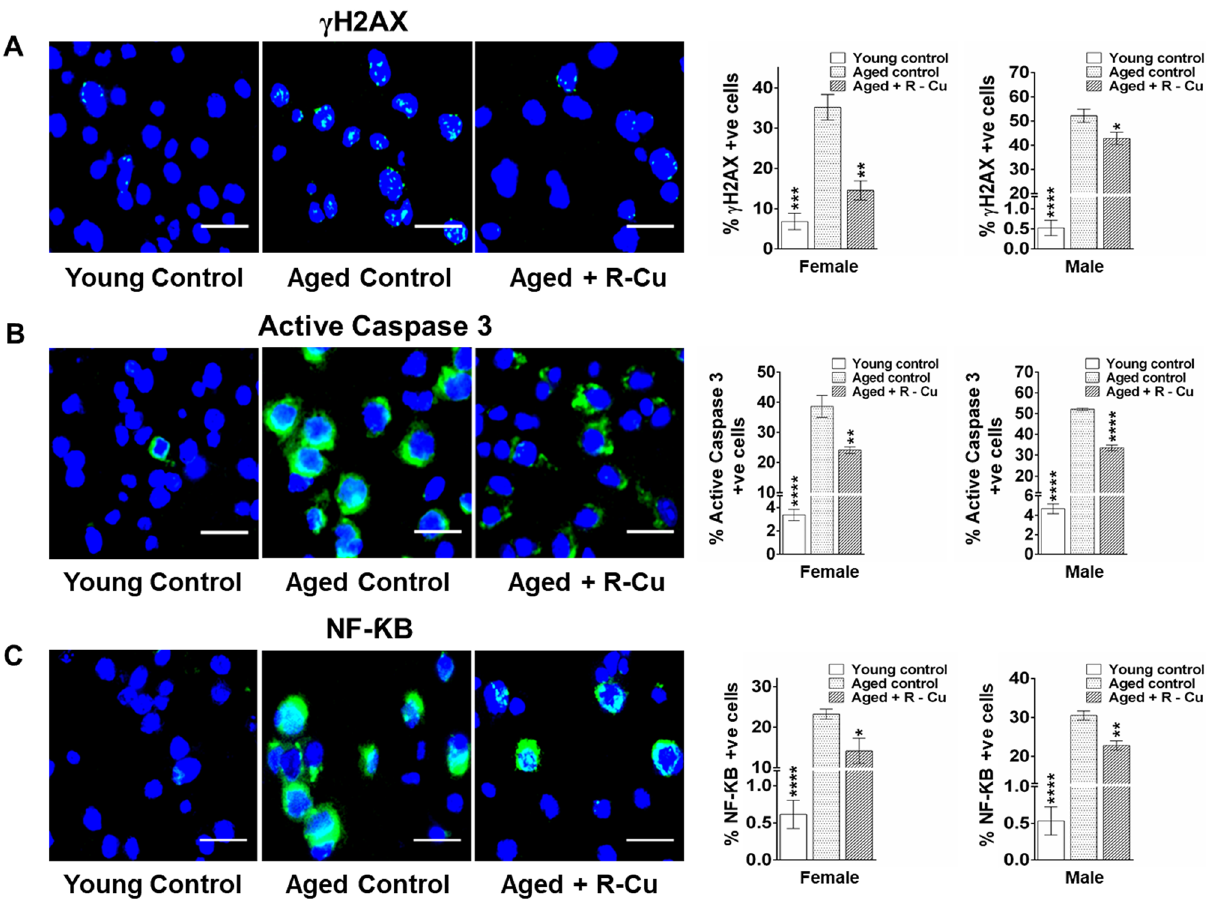
Figure 5. DNA damage, apoptosis and Inflammation in brain cells of ageing mice and their prevention by treatment with R–Cu. ( A ) Representative images of γH2AX expression (Scale bar = 10 µm) (left hand panel). Quantitative histograms (right hand panel). For each slide 1000 cells were analysed and percent cells positive for γH2AX were calculated. Bars represent mean ± SEM values. N = 4 animals in each group of both sexes. ( B ) Representative images of active caspase 3 expression (Scale bar = 10 µm) (left hand panel). Quantitative histograms (right hand panel). For each slide 1000 cells were analysed and percent cells positive for caspase-3 were calculated. Bars represent mean ± SEM values. N = 4 animals in each group of both sexes. ( C ) Representative images of NF-kB expression (Scale bar = 10 µm) (left hand panel). Quantitative histograms (right hand panel). For each slide 1000 cells were analysed and percent cells positive for NF-kB were calculated. Bars represent mean ± SEM values. N = 4 animals in each group of both sexes. For ( A–C ), levels in young controls and R–Cu treated ageing animals were compared with those of ageing controls, and statistical analysis was performed by two-tailed Student’s t test. * p < 0.05; ** p < 0.01; *** p < 0.001; **** p <